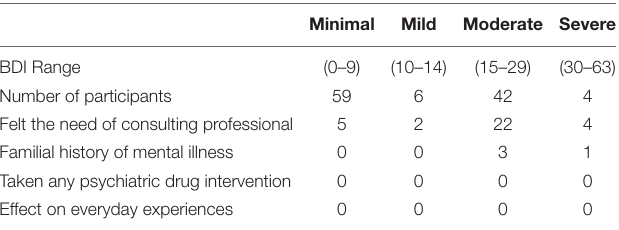
TABLE 1 | Distribution of participants across BDI